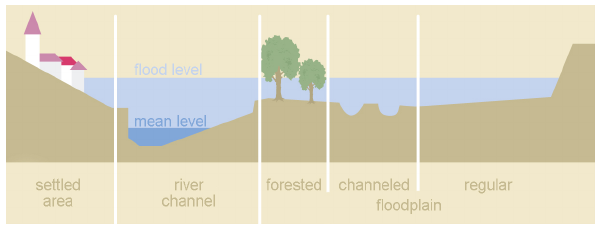
Figure 2. Scheme of homogenous units of floodplains with different hydraulic roughness characteristics (modified from Herget, 2012).